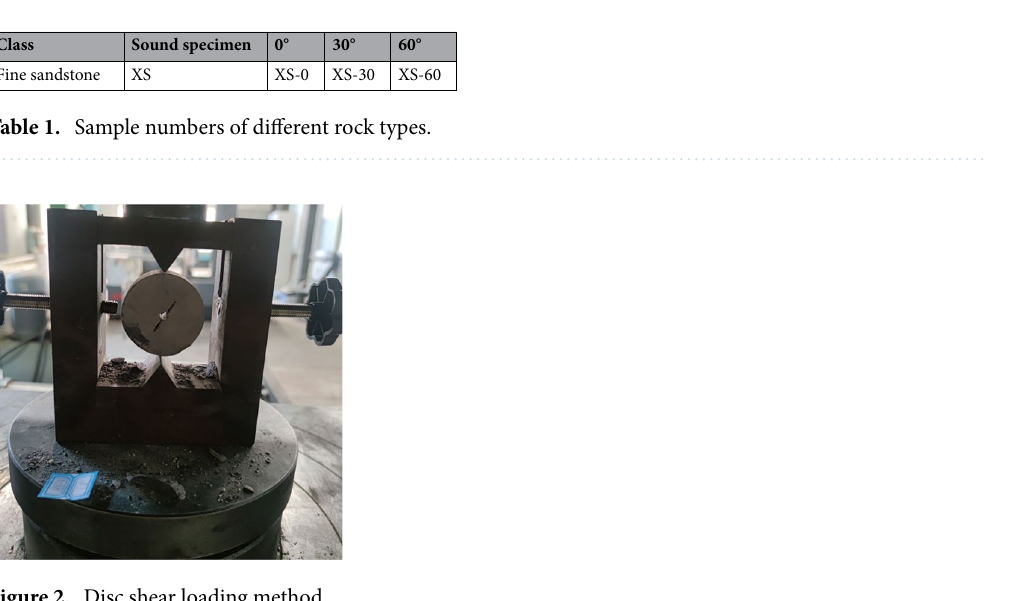
Figure 2. Disc shear loading